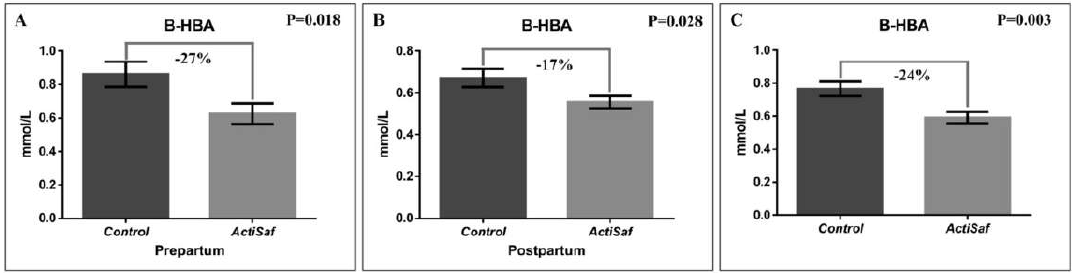
Figure 1. Graphical representation of ( A ) β -hydroxybutyric acid (B-HBA) in ewes’ blood prepartum (mean ± SE), ( B ) β -hydroxybutyric acid in blood postpartum (mean ± SE), and ( C ) β -hydroxybutyric acid in blood of ewes in Control (black, n = 51 ewes) and ActiSaf (grey, n = 53 ewes) groups in experimental period of 12 weeks (mean ± mean standard error (SEM)).